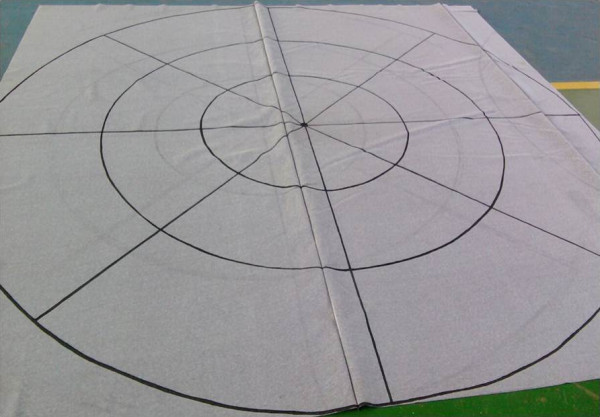
“Carpet” developed by researchers to evaluate the rotation and displacement of the patients.